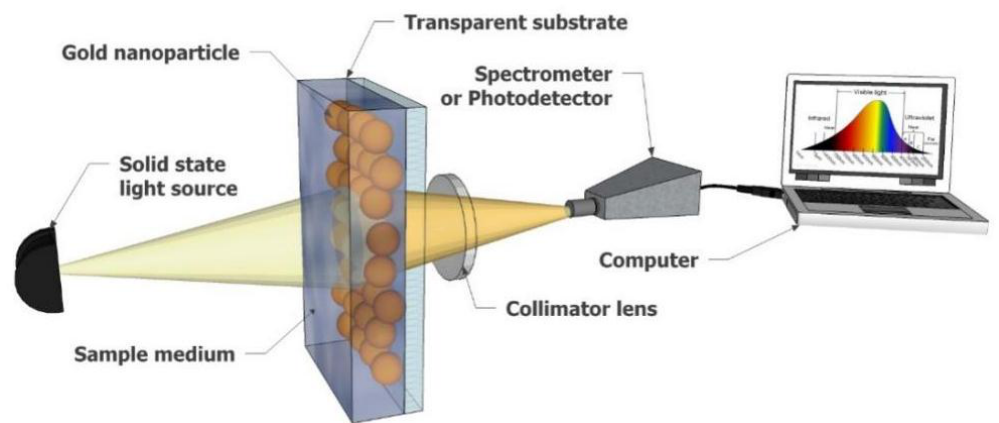
Figure 7. LSPR-based sensor using transmission attenuation configuration.